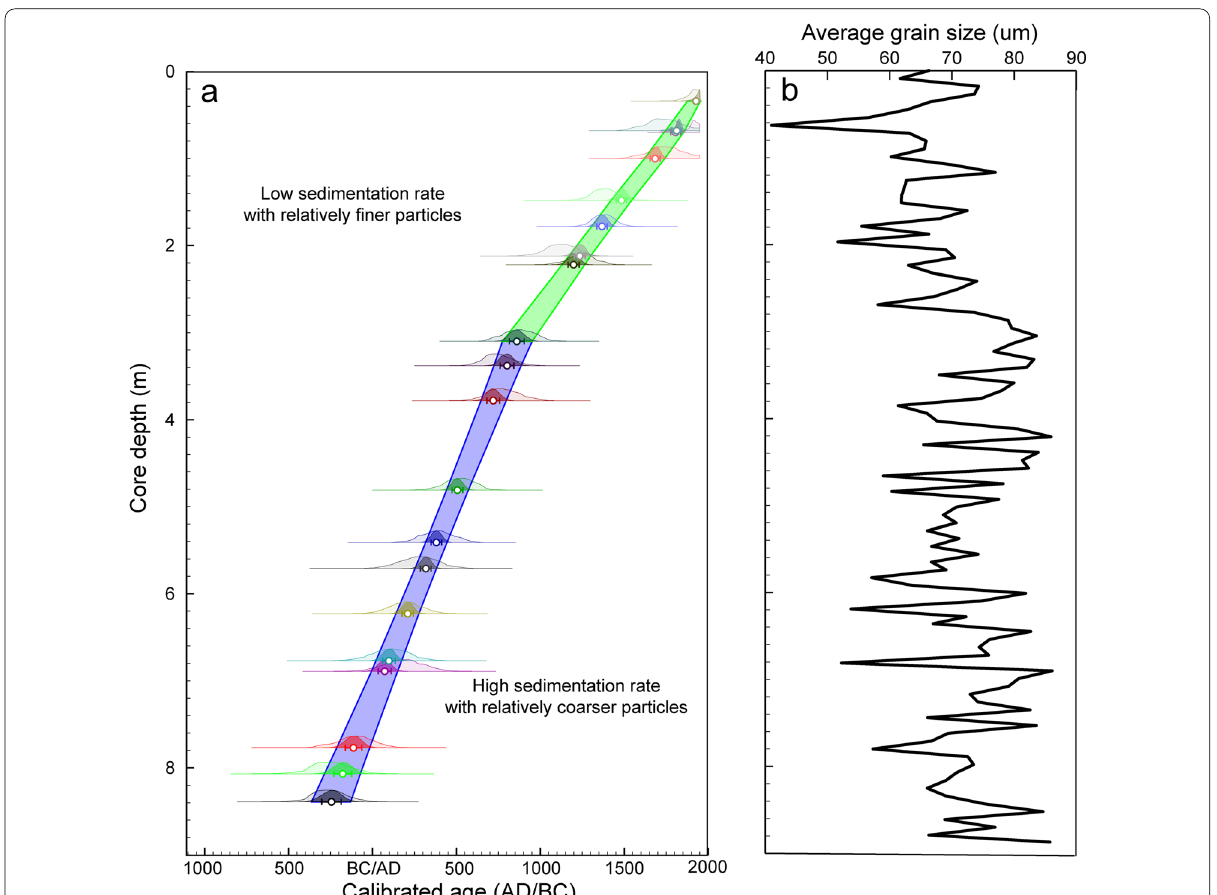
Fig. 3 a Core depth (cm) versus calibrated age of the piston core. For each 14 C age controlling point, P-sequence modeled and unmodeled age probability distributions are shown. The error bars represent the 1σ error of the P-sequence modeled age. b Average grain